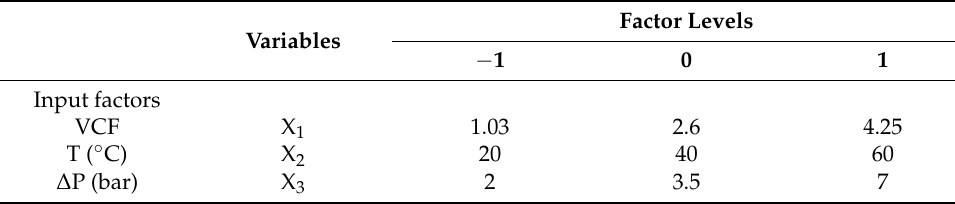
Factor Levels − 1